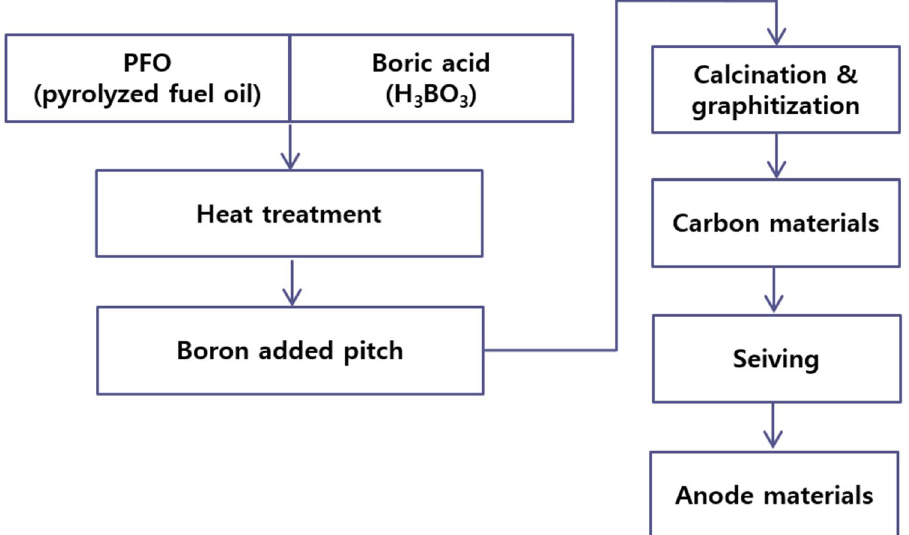
Fig. 1 Schematic diagram of the synthesis process for